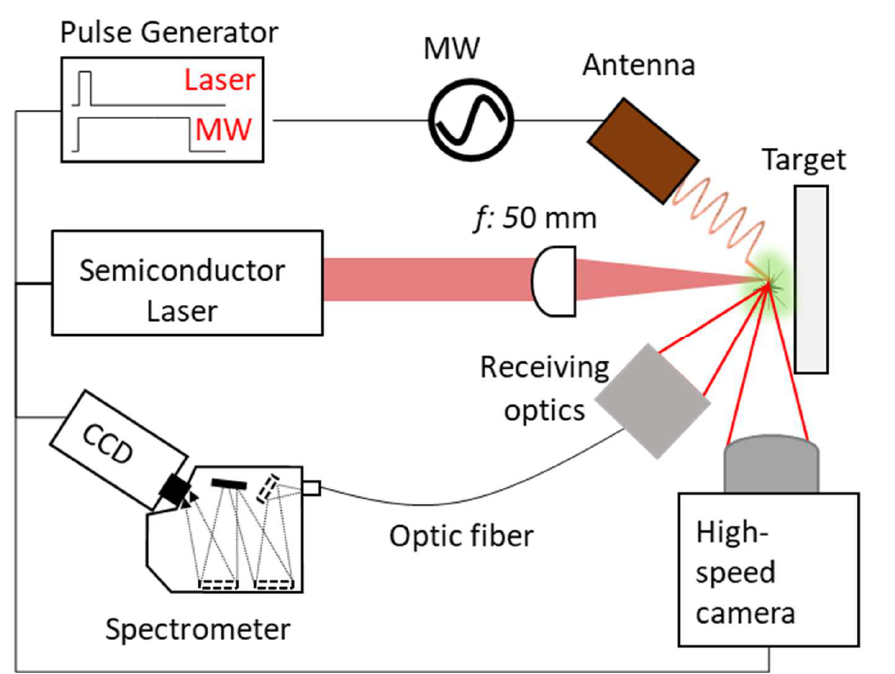
Figure 1. Measurement system: microwave-enhanced laser-induced breakdown spectroscopy.